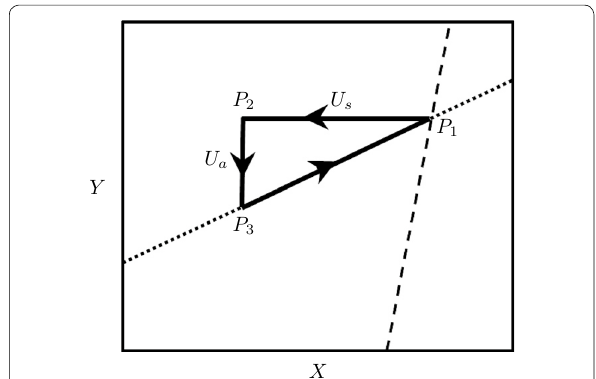
Fig. 6 Geometrical illustration of the cycle made of seismic slip, afterslip and interseismic creep. The dashed line is given by (38), rep- resenting the condition for asperity failure. The dotted line is given by (39), representing the condition for interseismic fault creep. The state of the fault is P 1 at the beginning of the seismic event, P 2 at the end of the event and P 3 at the end of afterslip. The lengths of the catheti are the amplitudes U s of seismic slip and U a of afterslip, respectively. From P 3 to P 1 , the fault is subject to tectonic loading and creep. Arrows indicate the motion of the representative point of the system during the